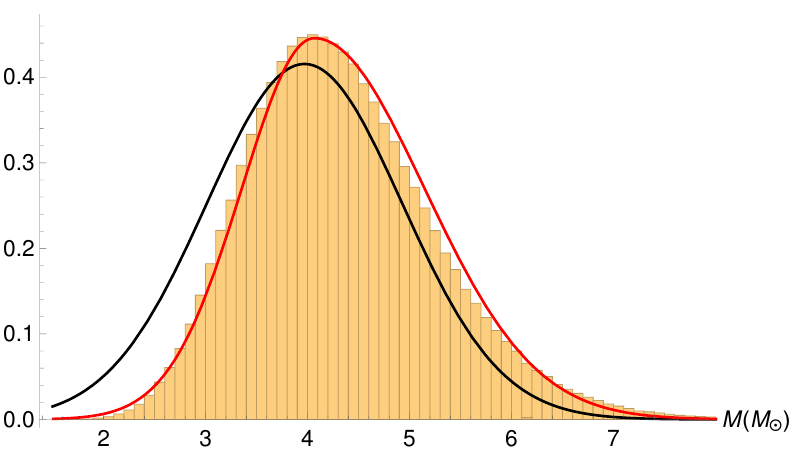
Figure 4. 10 6 Monte Carlo generated masses from GRO J0422+32 (histogram), along with the Gaussian distribution N ( 3.97,0.95 ) M (cid:12) from [99] (black line) and our fit of an asymmetric Gaussian AN ( 4.06,1.08,0.71 ) M (cid:12) (red line). The distributions N , AN are defined in the